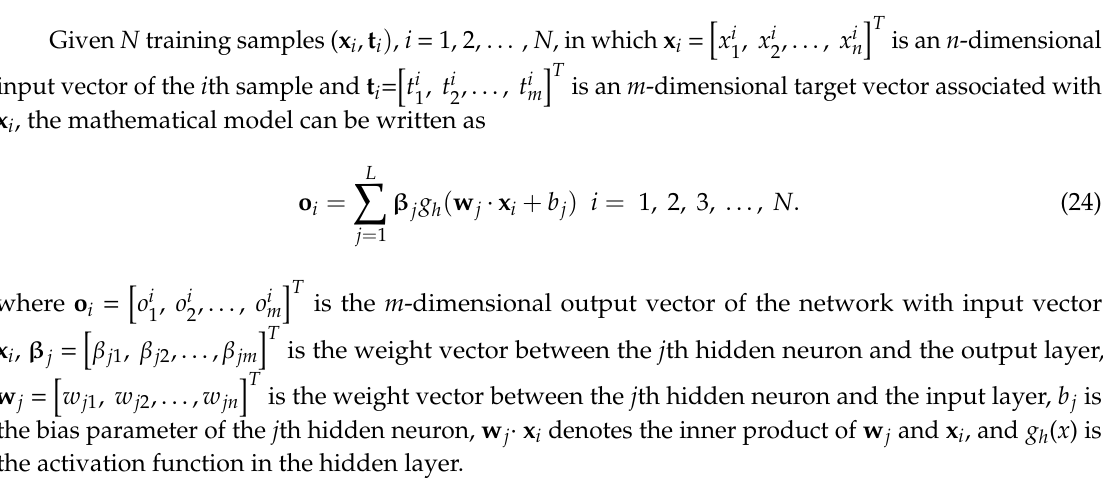
Figure 6. Structure of the extreme learning machine.